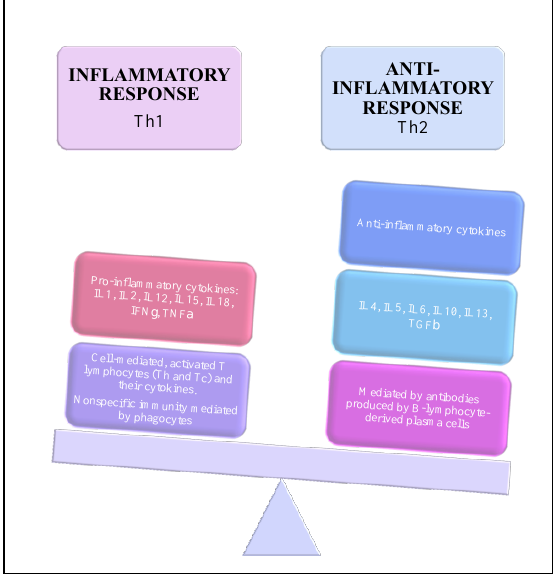
Figure 3. Immunological changes during the pregnancy.